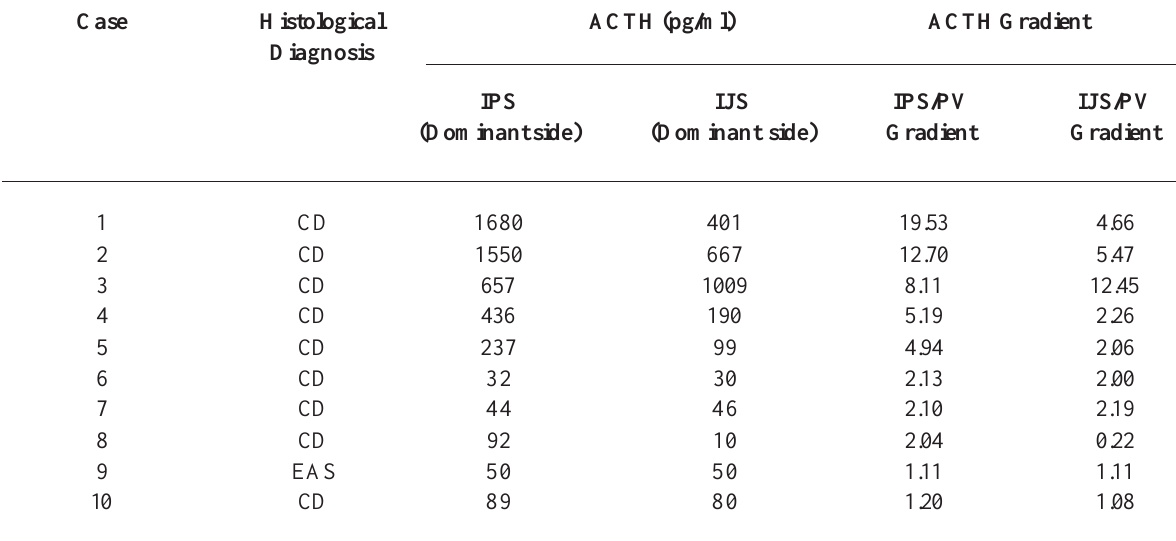
Table 1. Catheter study results (IPSS and